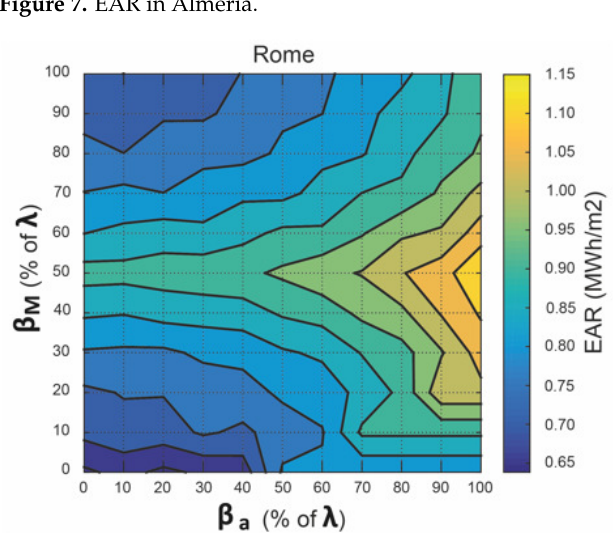
Figure 8. EAR in